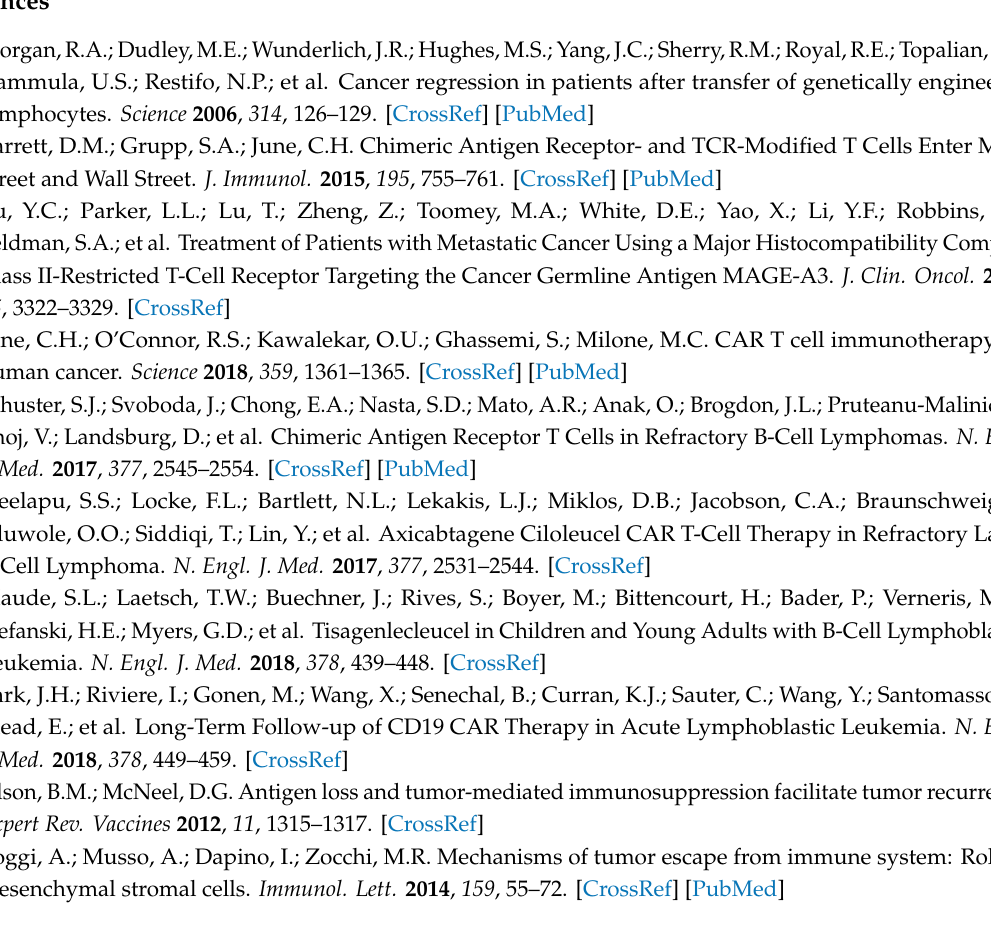
Figure S1: Gp100 TCR and CSPG4 CAR expression of TETARs, Figure S2: Antigen-specific IL-4 production of TETARs, Figure S3: TETARs show antigen-specific cytotoxicity. Table S1: p -values corresponding to Figure 2C, Table S2: p -values corresponding to Figure 3, Table S3: p -values corresponding to Figure 4 and Figure